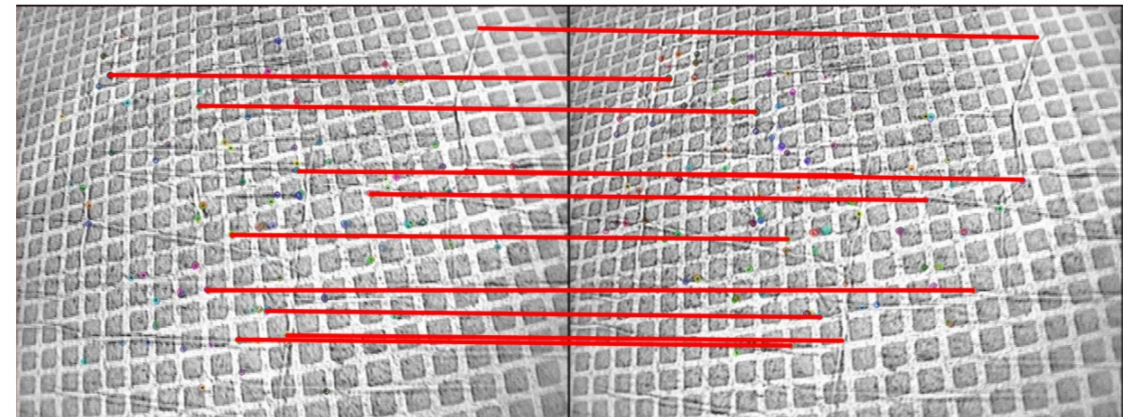
Figure 9. Feature points matching for velocity calculation.